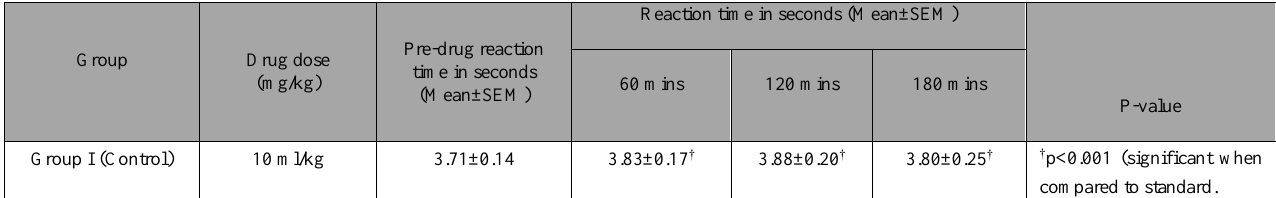
Table 1. Analgesic activity of the SXB aqueous extract in albino rats on the tail-flick test.